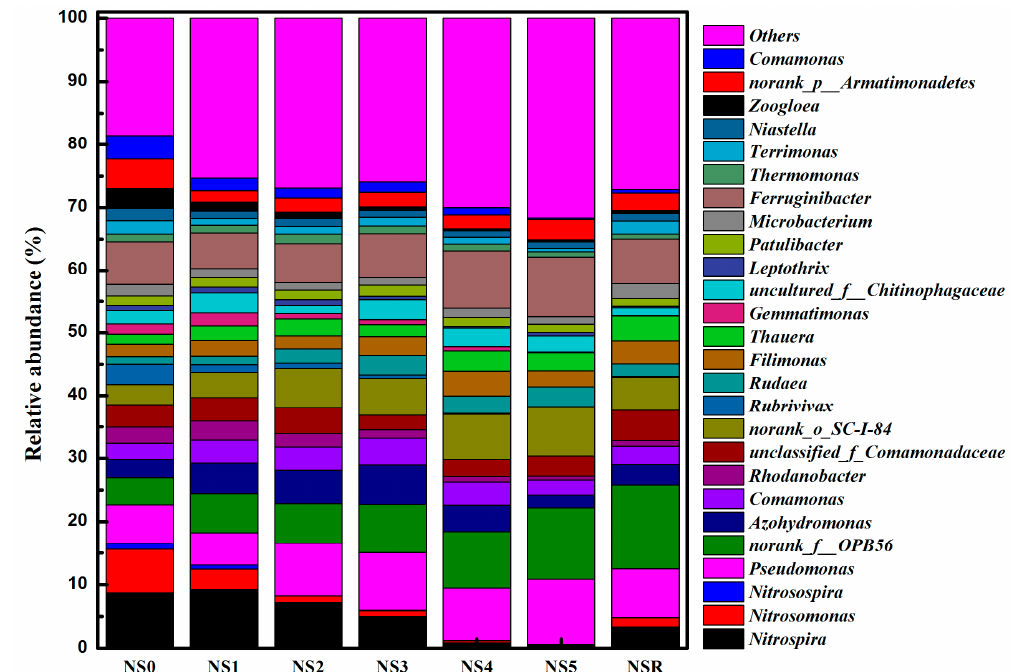
Figure 6. The relative abundance of the predominant microbial (>1% in any sample) in sludge samples (NS0, NS1, NS2, NS3, NS4, NS5, and NSR) at the genus level.